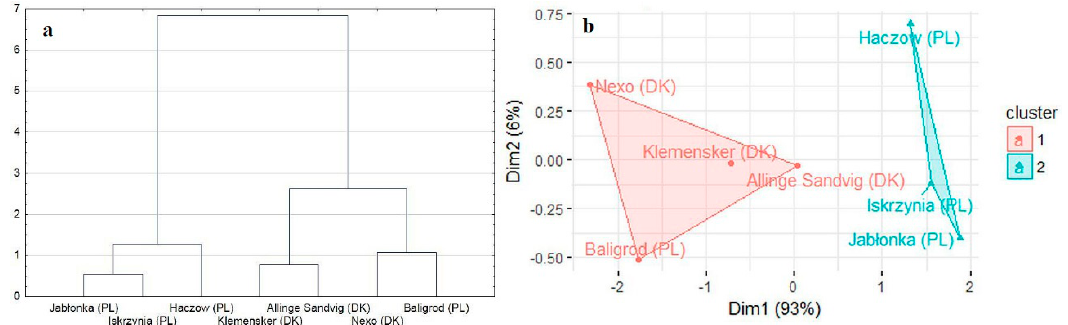
Figure 3. ( a ) Dendrograms showing the clustering algorithm after the utilization of principal component analysis; ( b ) Graph presenting final clusters after the utilization of principal component analysis.